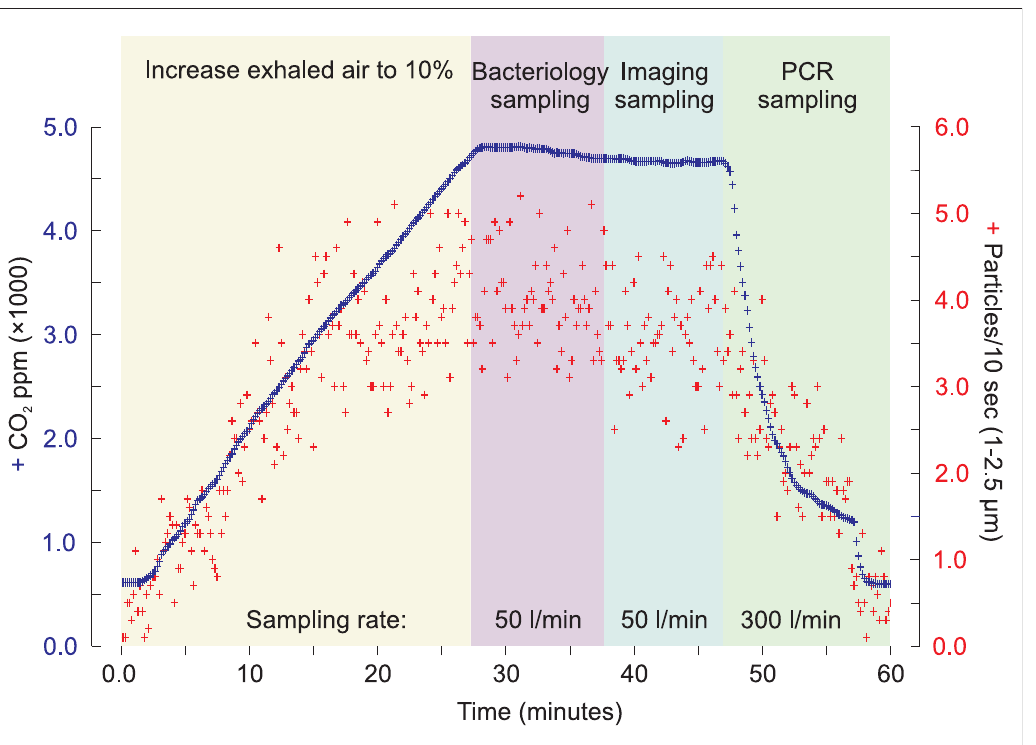
Fig 5. Particle production as a function of respiration in a clinical TB patient. CO 2 concentration (solid line and left ordinate) and particle counts (dots and right ordinate) in the 1 – 2.5 μ m size range for a TB patient.